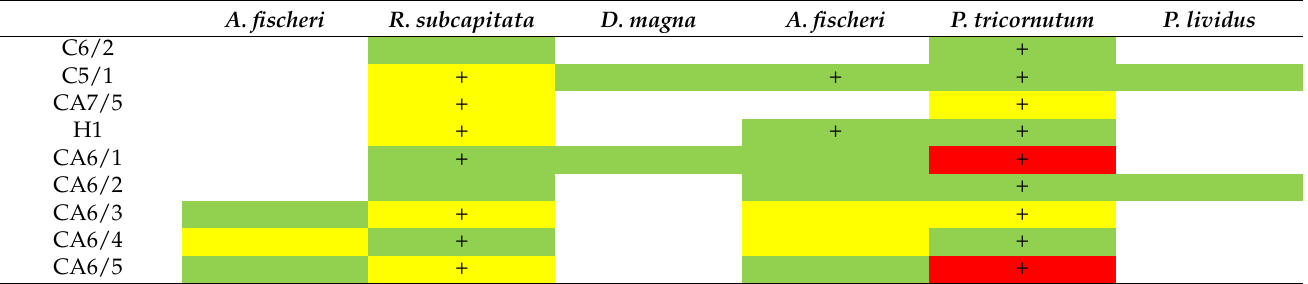
Table 4. Exceeding thresholds for effect, broken down by species and treatment type, with no distinction between different time points. The score can range from a minimum of 0 (white) to a maximum of 3 (red). Green corresponds to a score of 1 and yellow to 2.